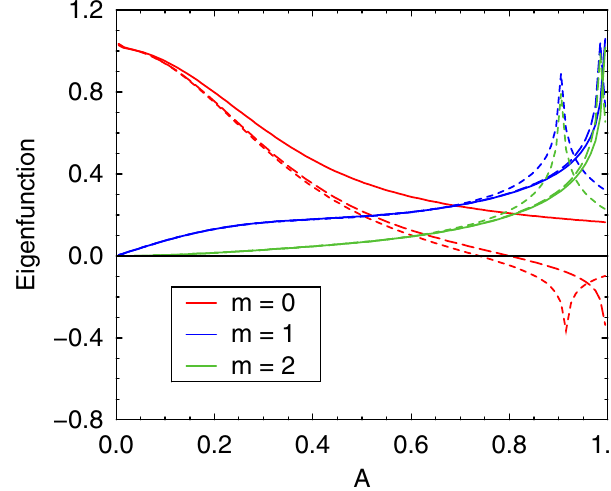
FIG. 13. (Color) Modified e.f. of the Gaussian